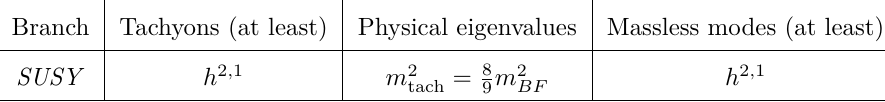
Table 3 . Massless and tachyonic modes for the supersymmetric